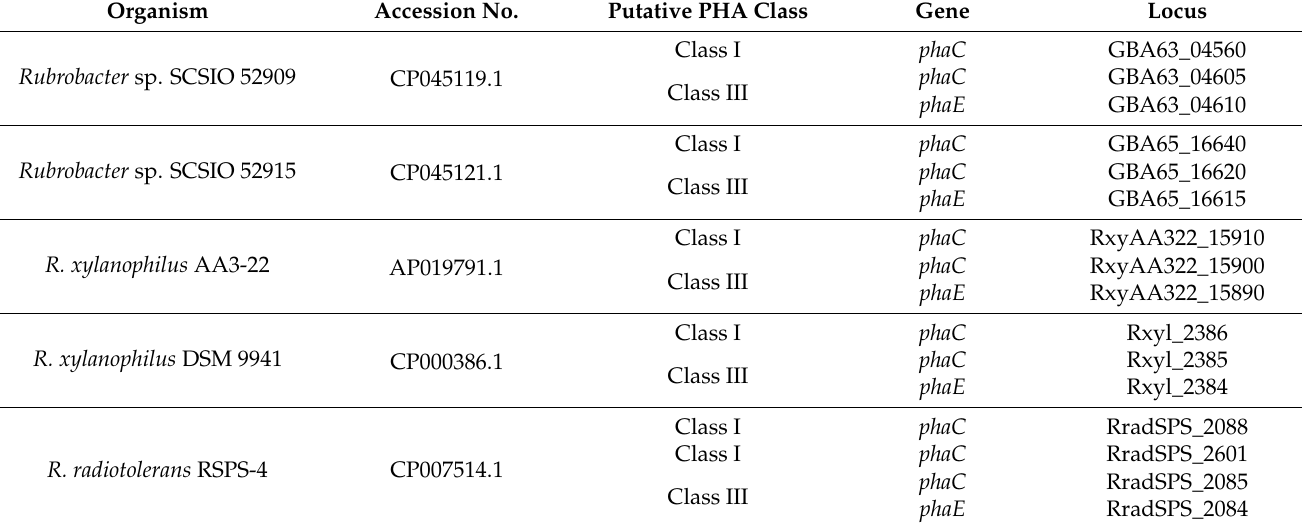
Table 1. Overview of PHA synthases in Rubrobacter species whose complete genomes are available in public databases. Organism Accession No. Putative PHA Class Gene Locus Rubrobacter sp. SCSIO 52909